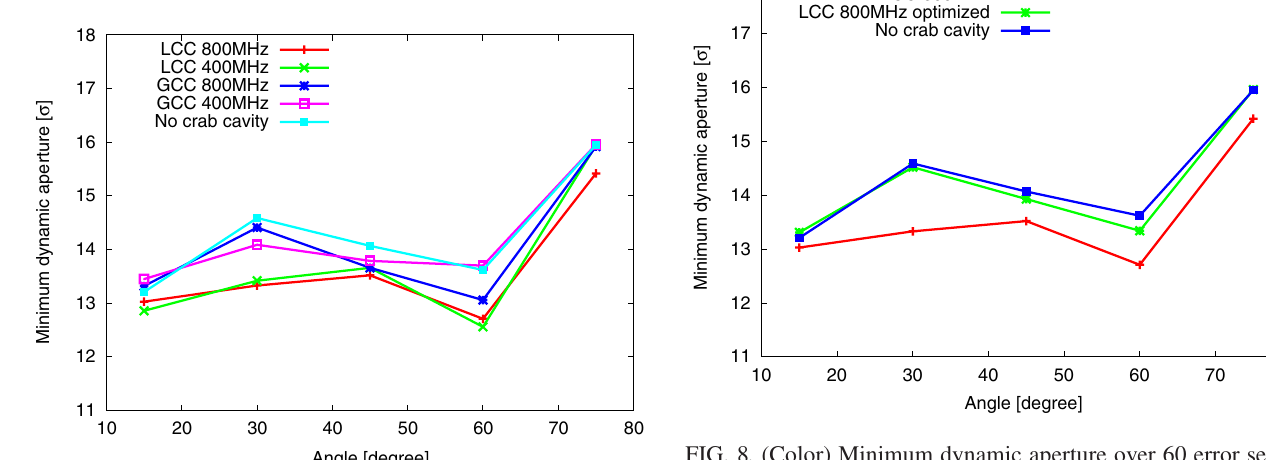
FIG. 8. (Color) Minimum dynamic aperture over 60 error seeds for nominal LHC optics, without crab cavity (blue); with two local 800-MHz crab cavities and horizontal phase advance 0.518 (in units of 2 (cid:4) ) between them (red); with two local 800-MHz crab cavities and optimized horizontal phase advance 0.5 (in units of 2 (cid:4) ) between them